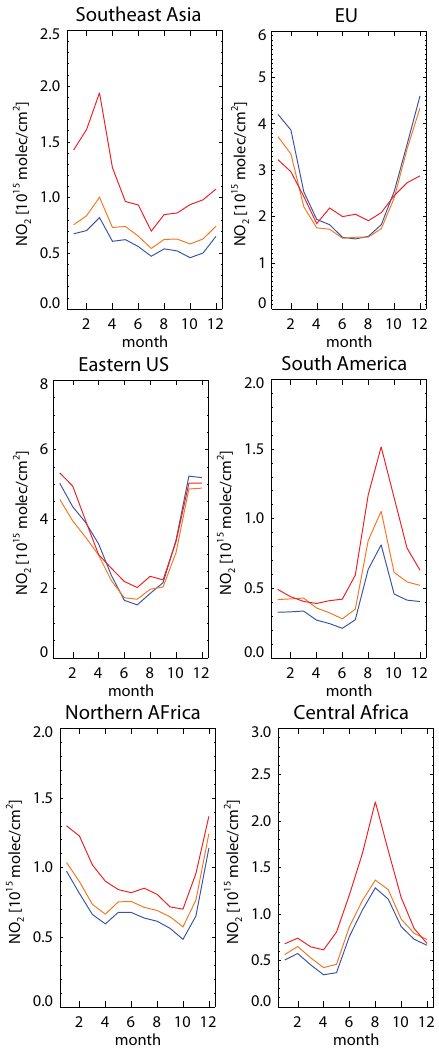
Fig. 8. The annual cycle of monthly averaged tropospheric columns of NO 2 for selected global regions for the BA (blue), MBA (dark yellow) and OMI DOMINO v2 (red). The definition of the regions is thus: Southeast Asia (98–105 ◦ E, 10–20 ◦ N), Eu- ropean Union (10 ◦ W–30 ◦ E, 35–60 ◦ N), Eastern US (71–90 ◦ W, 31–43 ◦ N), South America (50–70 ◦ W, 0–20 ◦ S), Northern Africa (20 ◦ W–40 ◦ E, 0–20 ◦ N) and Central Africa (10–40 ◦ E, 0–20 ◦ S).